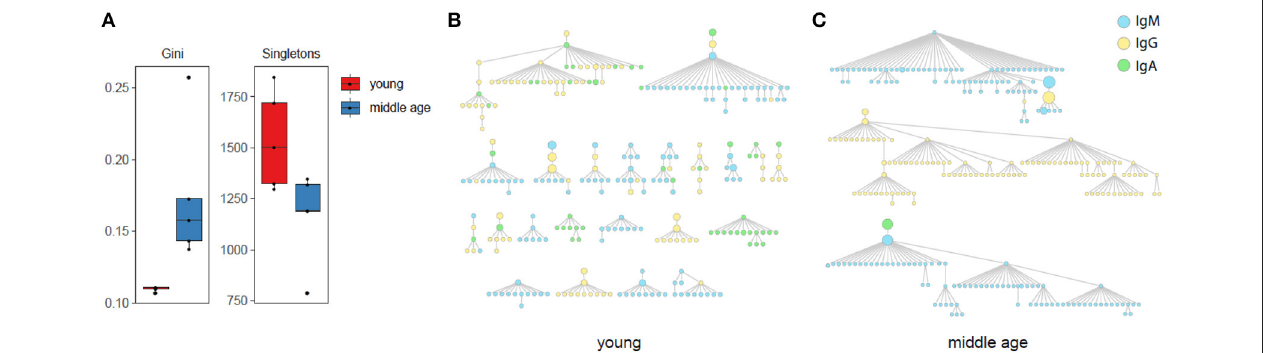
FIGURE 3 | Antibody lineage analysis. (A) Diversity of antibody lineages: Gini inequality coefficient for the number of nodes (clonotypes) in a tree (clone), and number of “trees” that include only one node. Both parameters are significantly different ( p < 0.05) between young and middle-age donors. Two-tailed T- test, p -values adjusted using Benjamini & Hochberg method. (B,C) Top IGH trees by size containing equal number of 270 nodes for united data of all young (B) and middle-age (C) individuals are